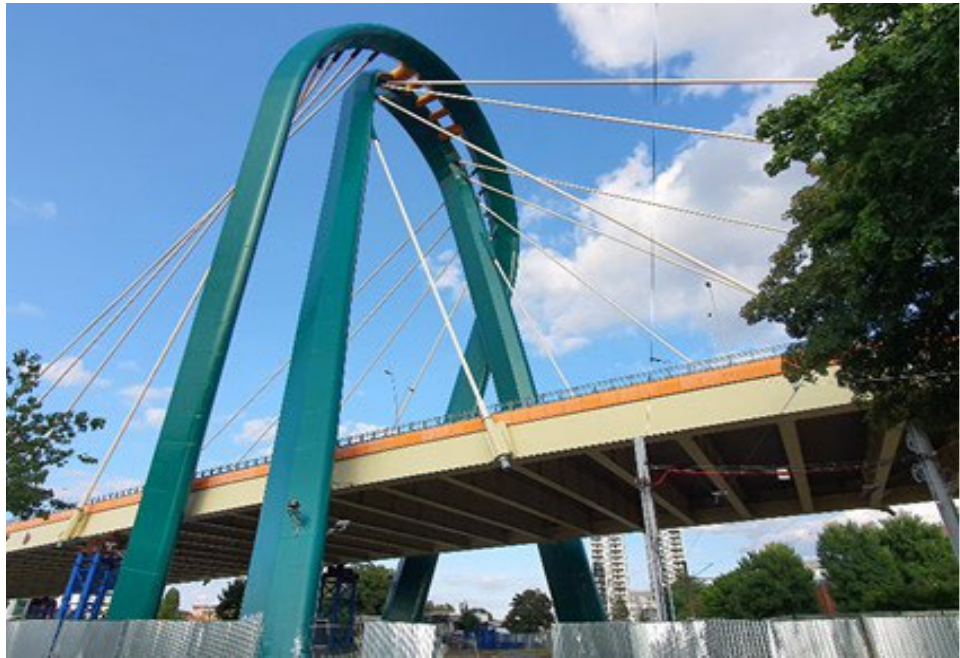
Figure 3. Closed bridge during repair works (photo: 21 August 2021).